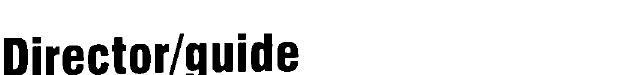
• Effective utilisation of